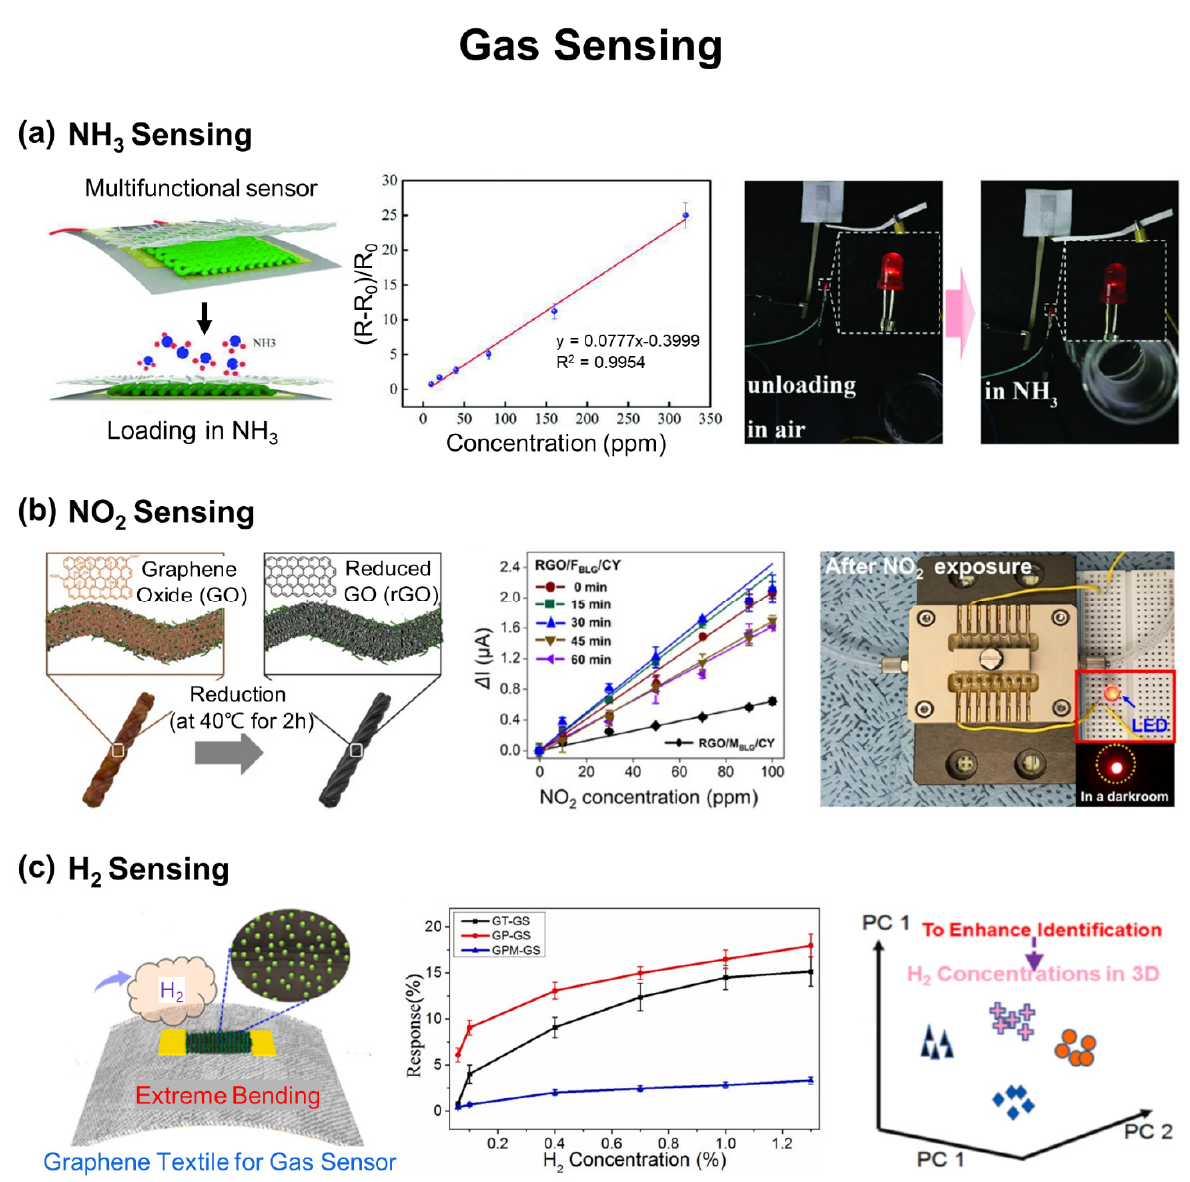
Figure 5. E-textiles for gas sensing. ( a ) NH 3 sensing with the polyaniline@textile. Reprinted with permission from [104]. Copyright 2018 Wiley-VCH. ( b ) NO 2 sensing with Amyloid/rGO yarns. Reprinted with permission from [117]. Copyright 2020 American Chemical Society. ( c ) H 2 sensing with rGO/Pd NP-coated fabrics. Reprinted with permission from [94]. Copyright 2021 Elsevier B.V.